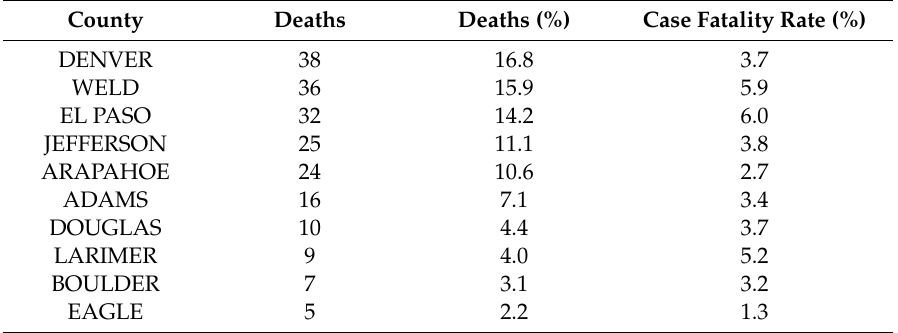
Table 2. Top ten counties by percentage of deaths and case fatality rates in Colorado by April 8,